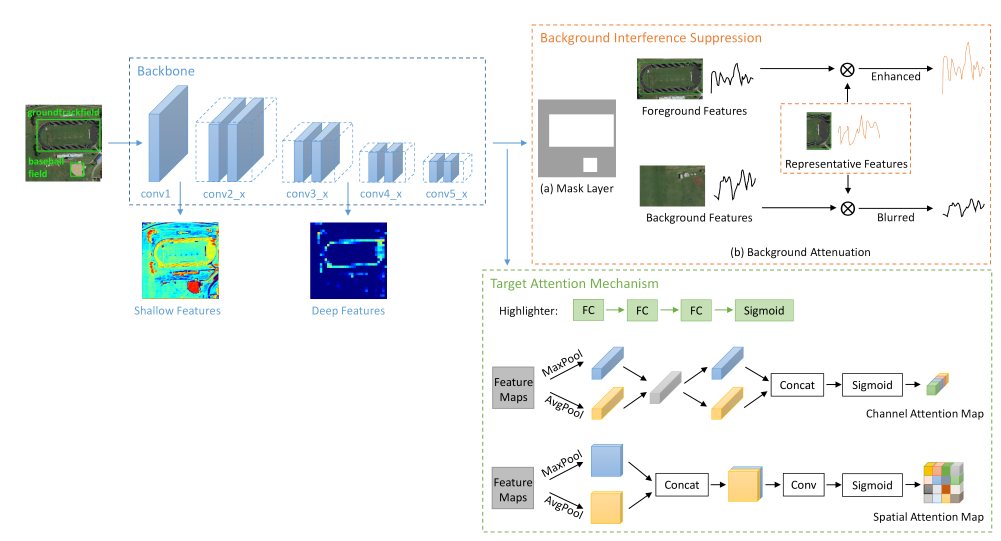
Figure 11. The illustration of high- and low-level semantic feature extraction, background interference suppression, and target attention mechanism. Details can be found in Section